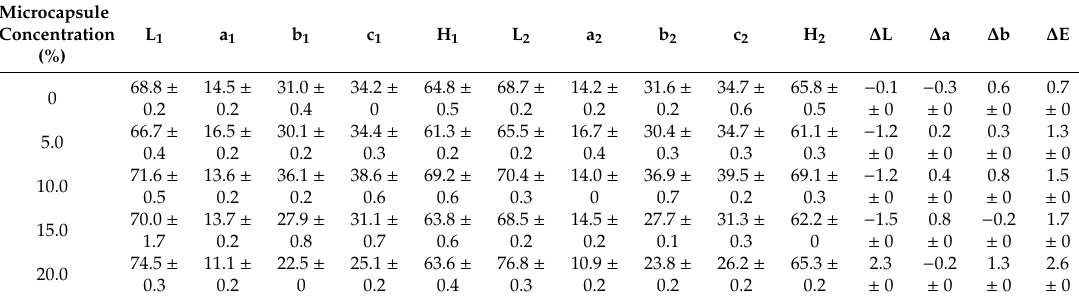
Table 5. E ff ect of microcapsule concentration with 0.75:1 core-wall ratio on the color di ff